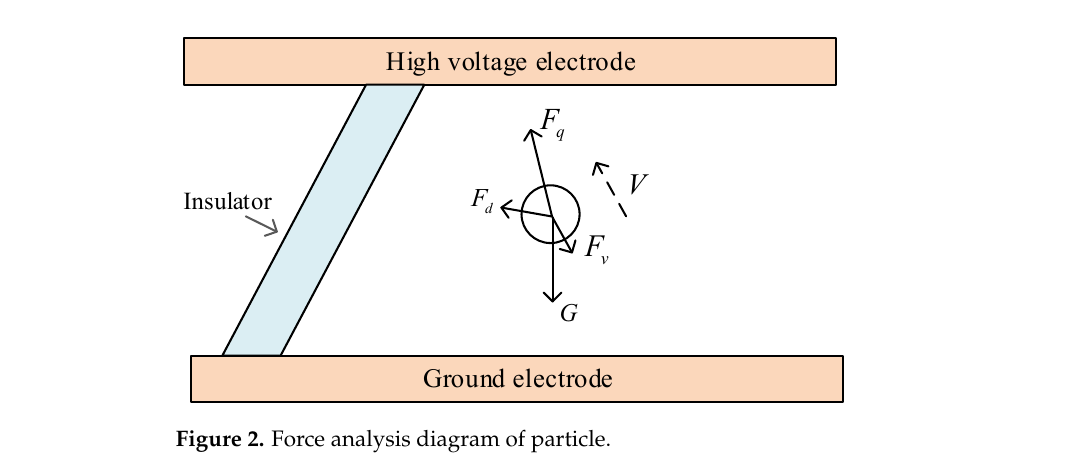
Figure 1. Structure diagram of GIL: ( a ) outside and ( b ) inside.